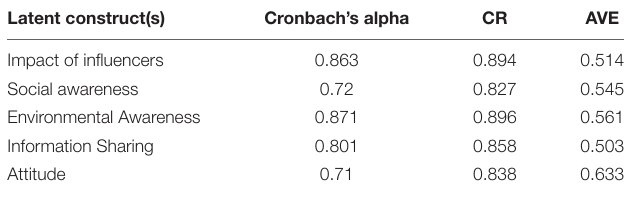
TABLE 2 | Reliability and validity.